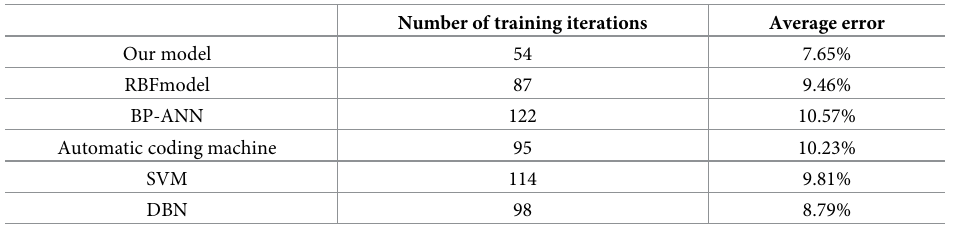
Table 2. Comparison of errors between different models.